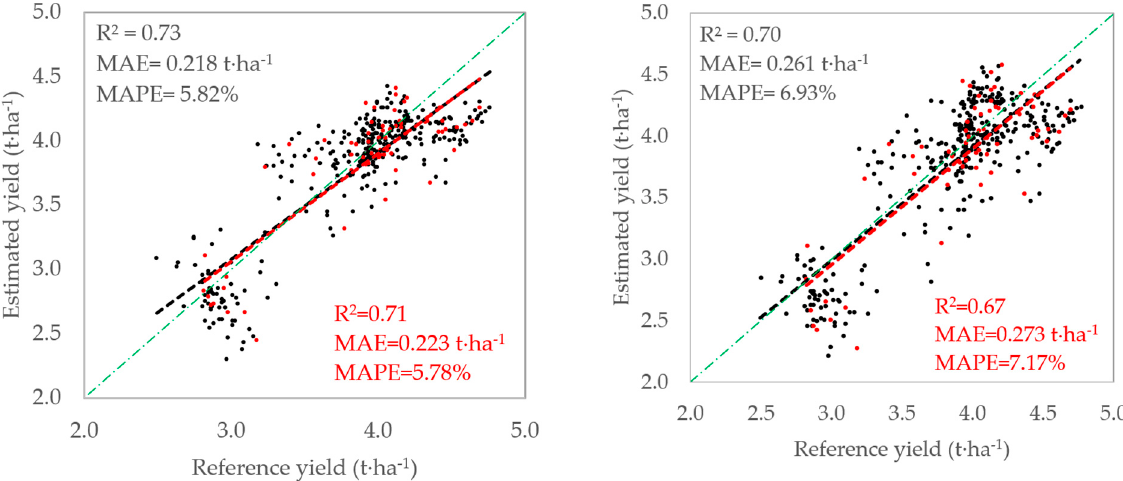
Figure 6. Validation of the Bomba models on July 4 at validation area: M1B+ (black) and M3B+ (red) ( left ); M1B (black) and M3B (red) ( right ).